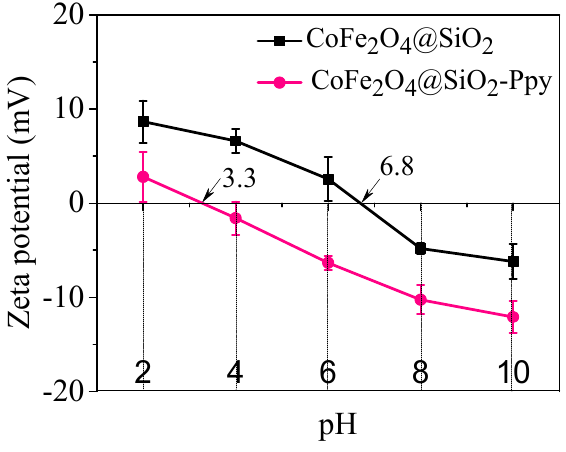
Figure 9. Zeta potentials of CoFe 2 O 4 @SiO 2 and CoFe 2 O 4 @SiO 2 -Ppy.